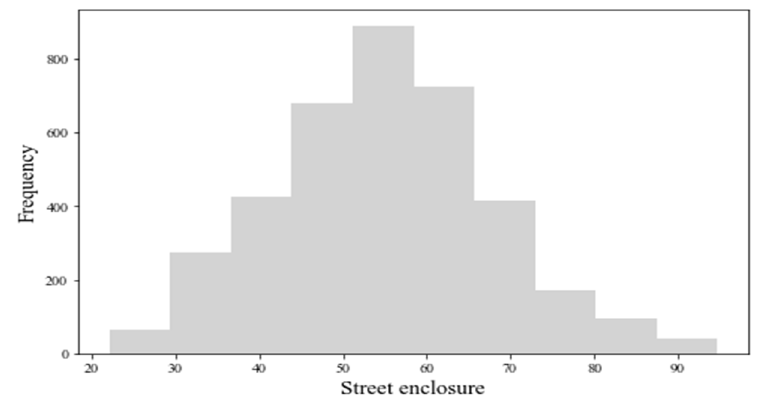
Figure 9. Street enclosure histogram .